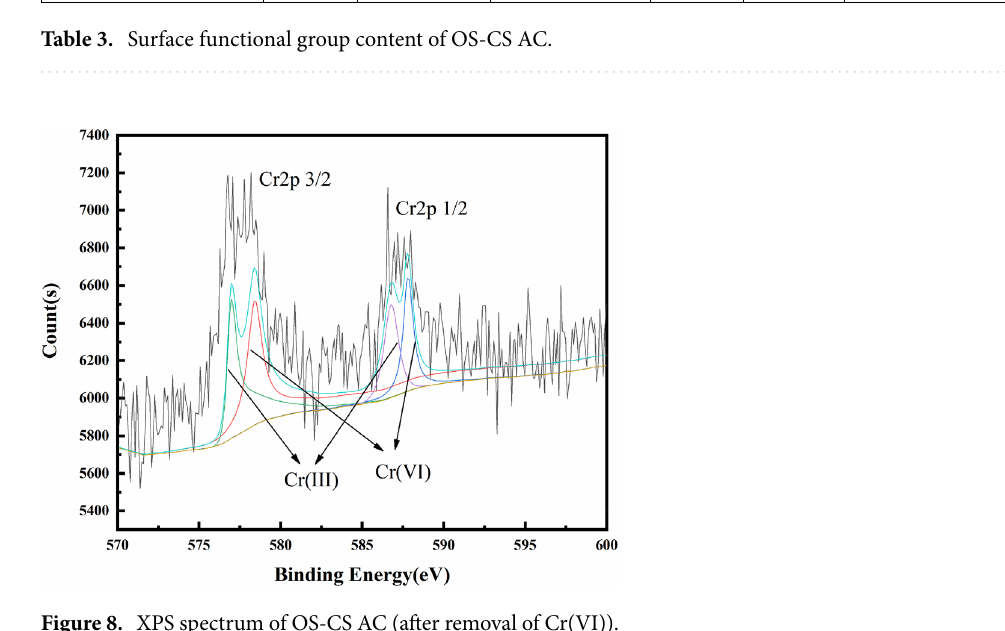
Figure 8. XPS spectrum of OS-CS AC (after removal of Cr(VI)).